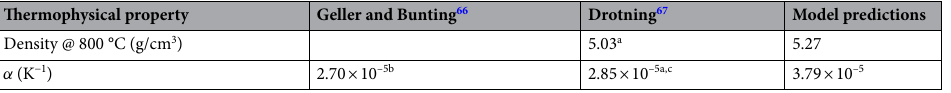
Table 5. Comparisons of model predictions with experimental data for 50–50 mol% PbO–B 2 O 3 . a Polynomial extrapolation of experimental data. b Interpolated average from room temperature to 250 °C. c Mean value from 50 to 300